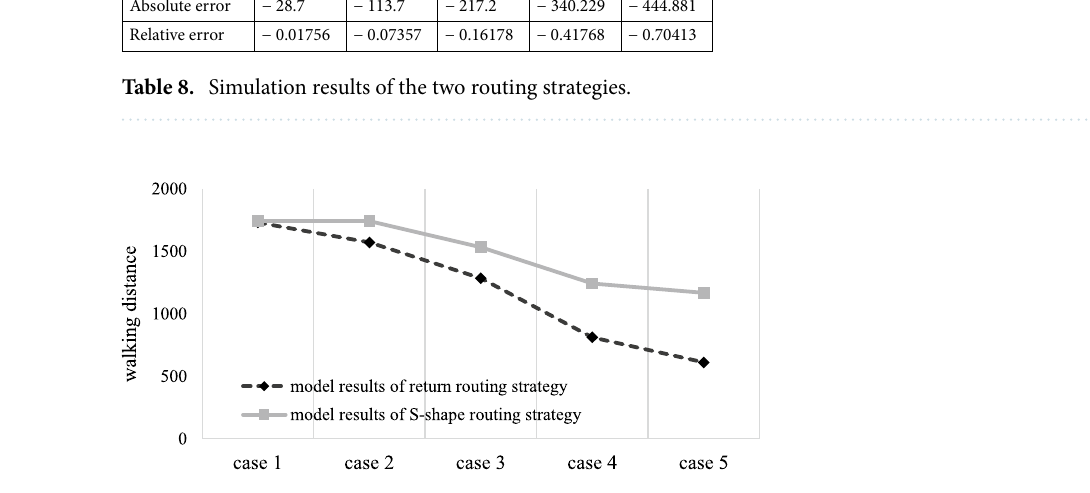
Figure 7. Comparison of model results of the two routing strategies.